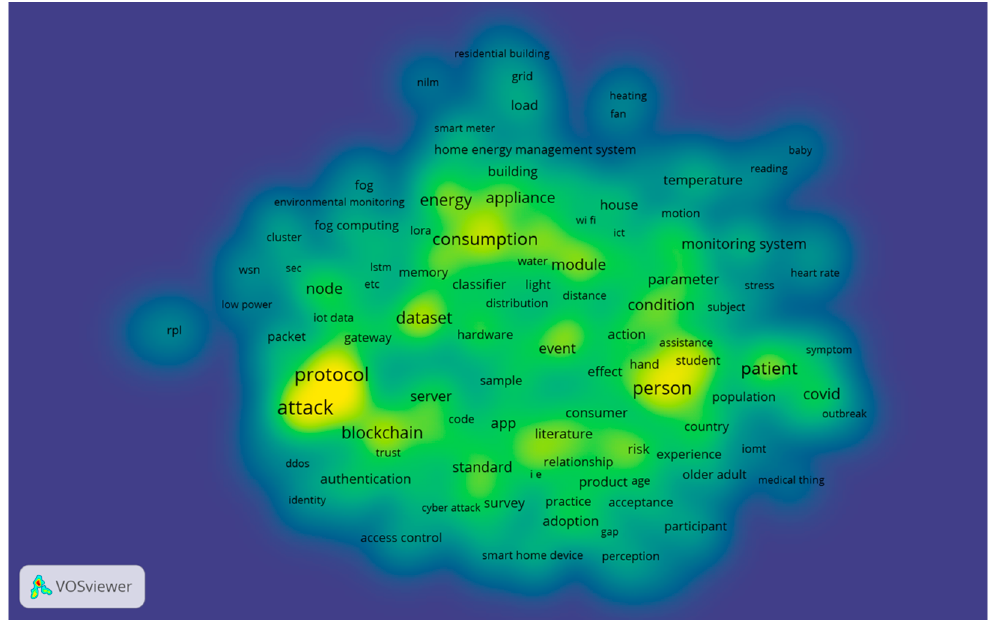
Figure 17. Density visualization for 2020.